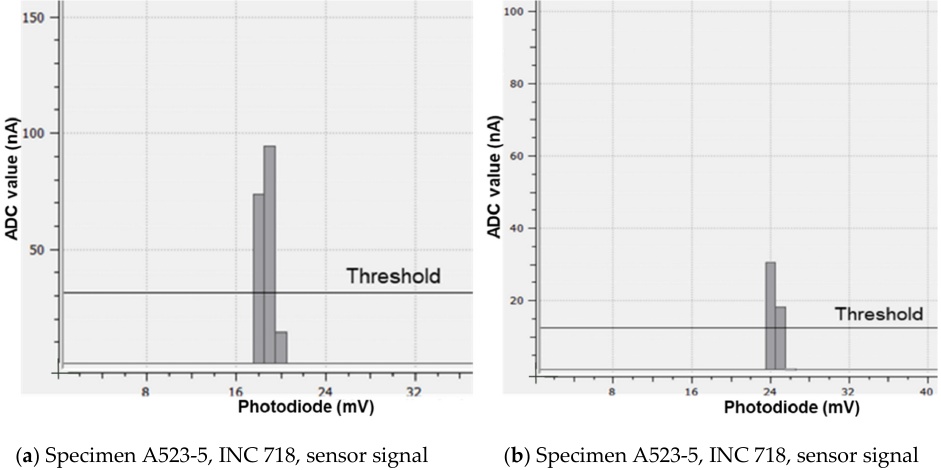
( a ) Specimen A523-5, INC 718, sensor signal strength at room temperature.